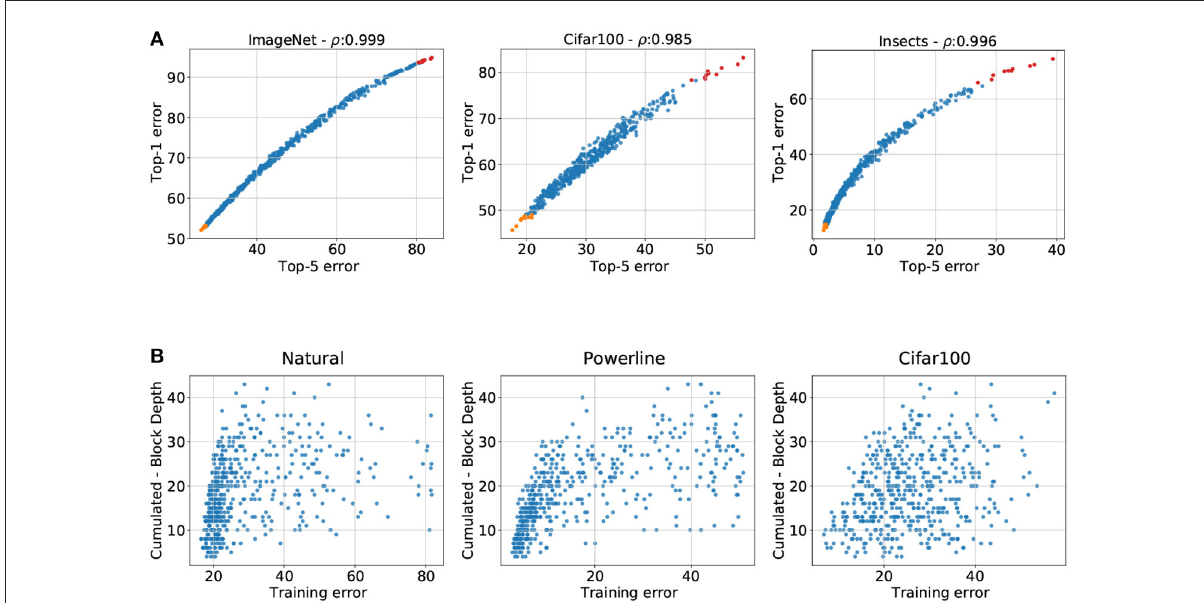
FIGUREA4 (A) Top-1 error plotted against top-5 error of all 500 architectures on ImageNet, Cifar100, and Insects. The plots reveal that on all three datasets the errors have a very close relationship: it is not perfectly linear but is monotonically ascending. (B) Training errors of the sampled architectures (x-axis) plotted against the cumulated block depth for the 3 datasets that have the lowest test errors on shallow architectures. We observe that for all three datasets shallow architectures also have the lowest training errors. Therefore overfitting is not the cause of this behaviour.